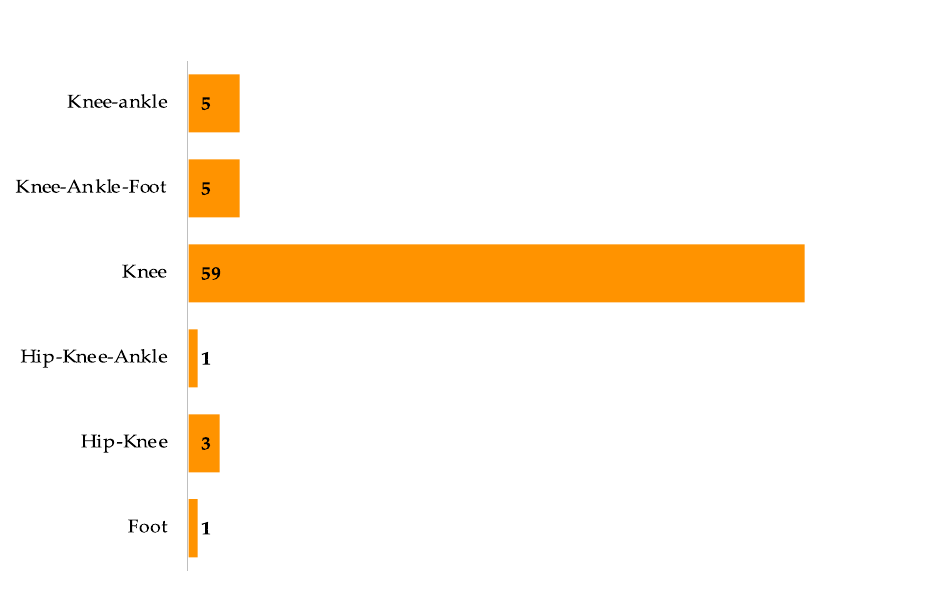
Figure 5. Top patent applicants for exoskeletons and orthosis.